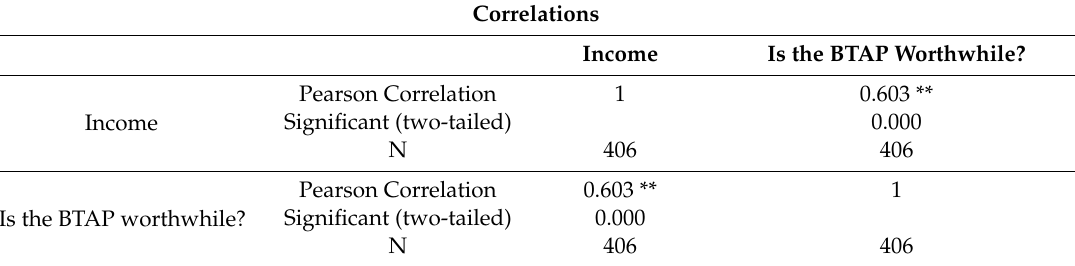
Table A3. Income correlations